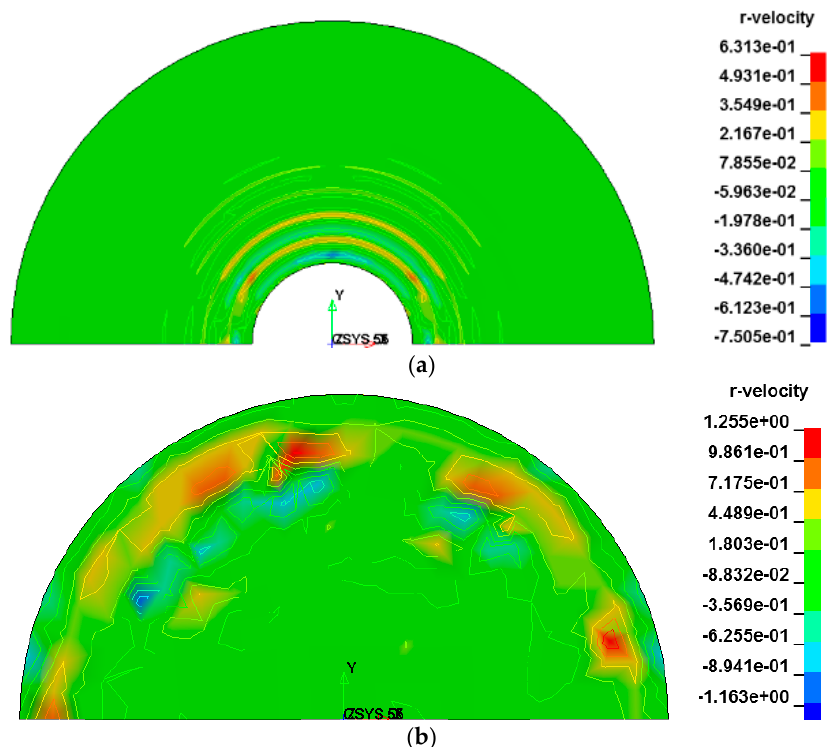
Figure 20. The velocity counter of the air part with a thickness of 0.01m, P12, when t = 1.20 s. ( a ) Air part outside. ( b ) Air part inside.